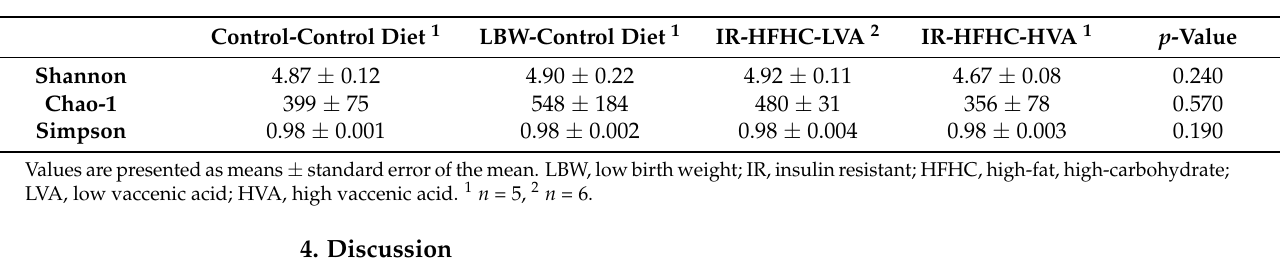
Table 8. Alpha diversity of cecal bacteria in LBW and Control pigs fed HFHC and VA-enriched